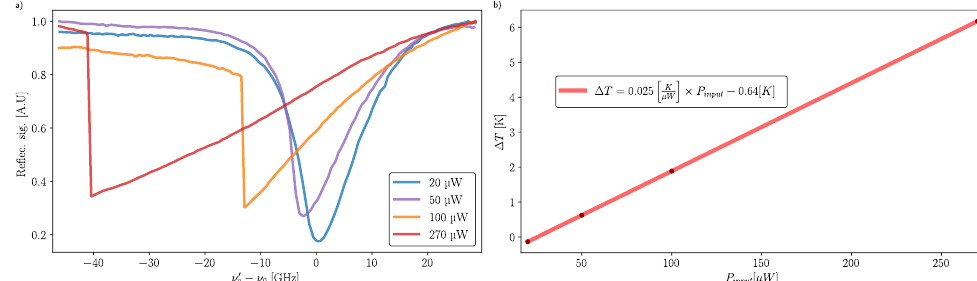
Figure 12. Bistability of the optical resonance frequency with increasing input power. ( a ) Evolution of the Lorentzian optical mode into a bistable one with increasing power. ( b ) The local minima of each curve of Figure 12a are plotted against the input power and linearly fitted to extract the shift